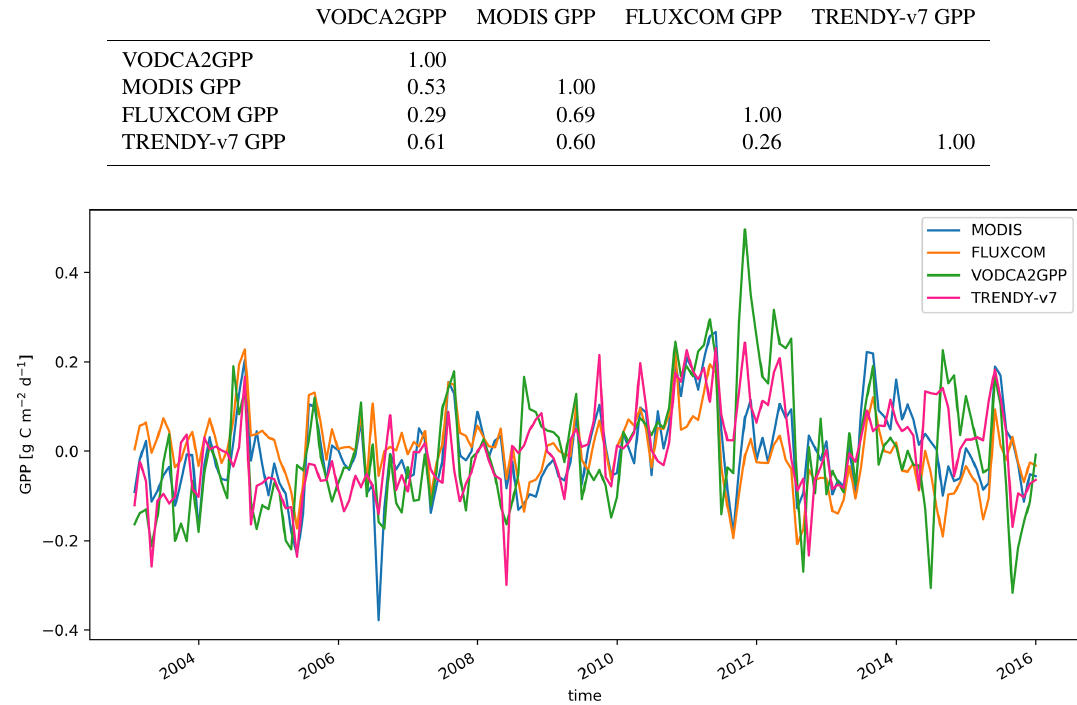
Figure 6. Time series of mean global monthly GPP